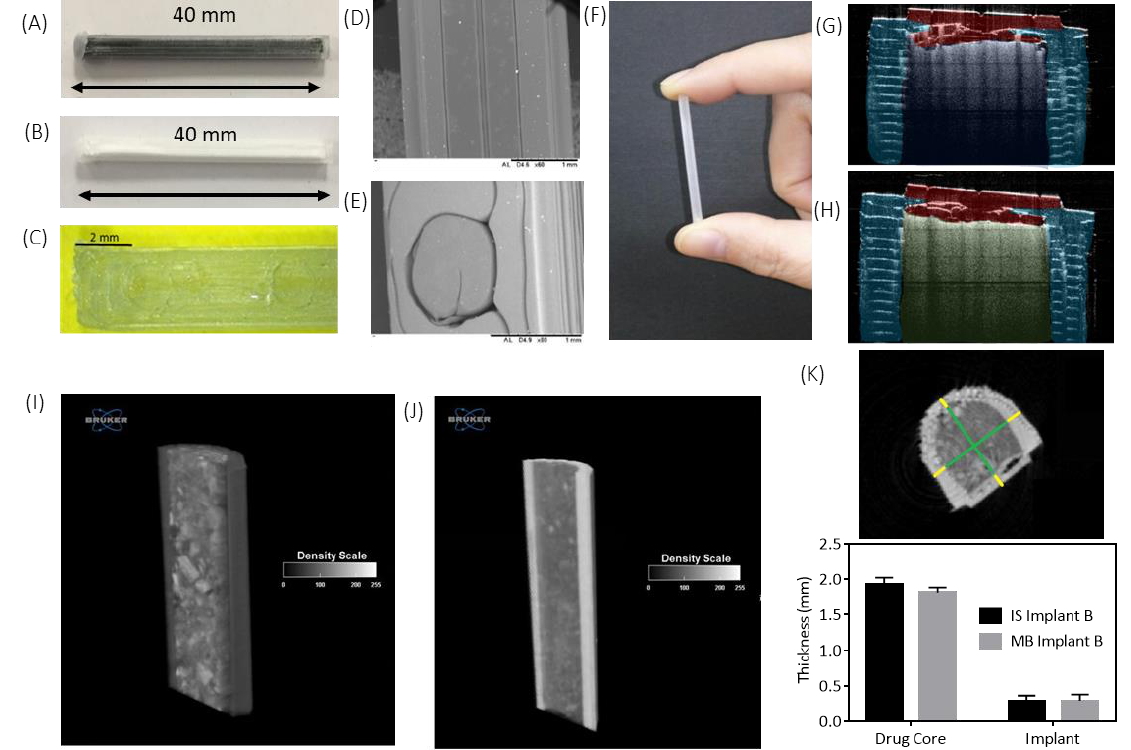
Figure 3. Images of ( A ) methylene blue-filled implant (Implant B); ( B ) ibuprofen sodium-filled